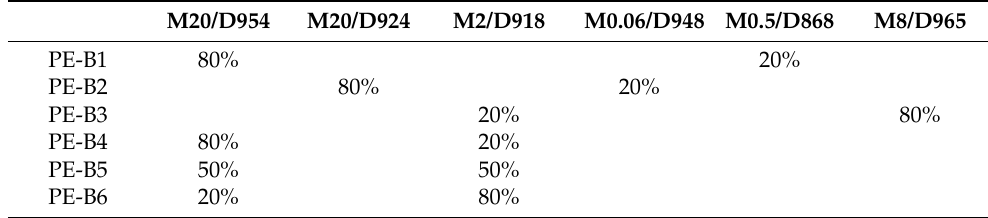
Table 1. Basic formula of polyethylene blends.